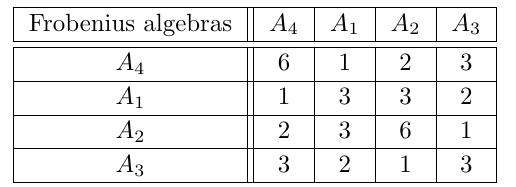
on a cylinder, whose boundaries are S 3 S 3